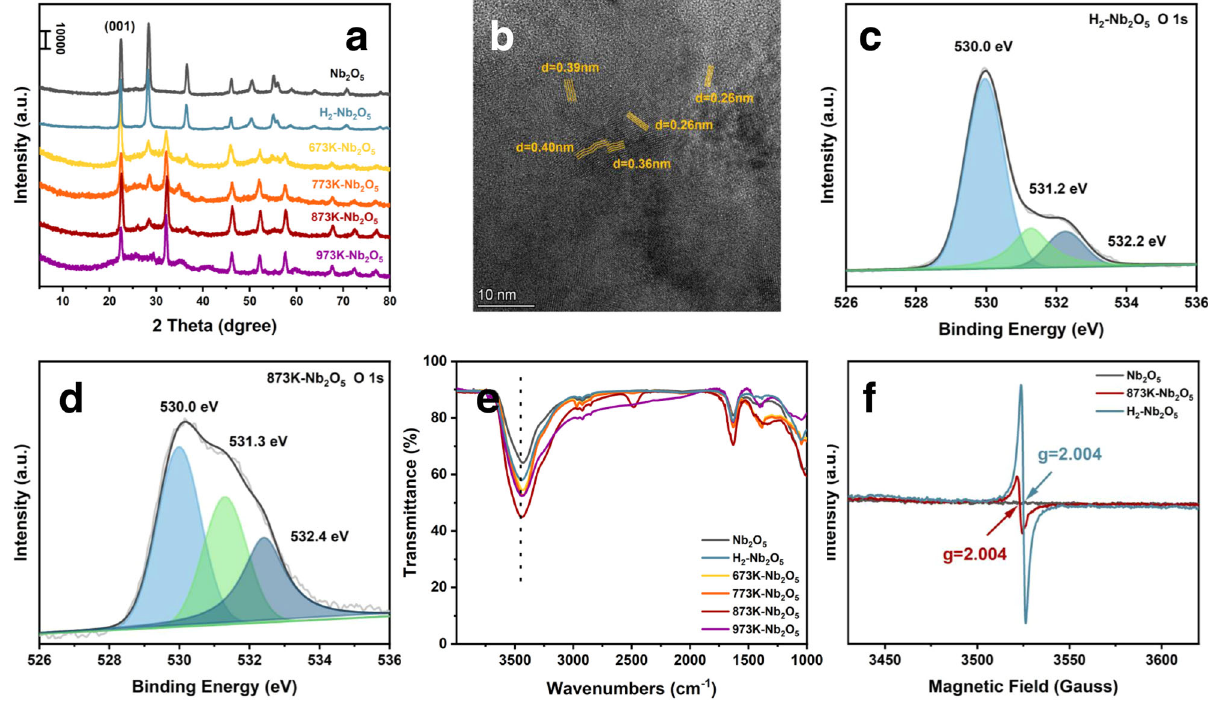
Fig. 1 | Crystal structure and defect analysis. a XRD patterns of Nb 2 O 5 samples. b HRTEM image of 873K-Nb 2 O 5 . O 1s XPS spectra of ( c ) H 2 -Nb 2 O 5 and ( d ) 873K-Nb 2 O 5 . e FTIR spectra of different